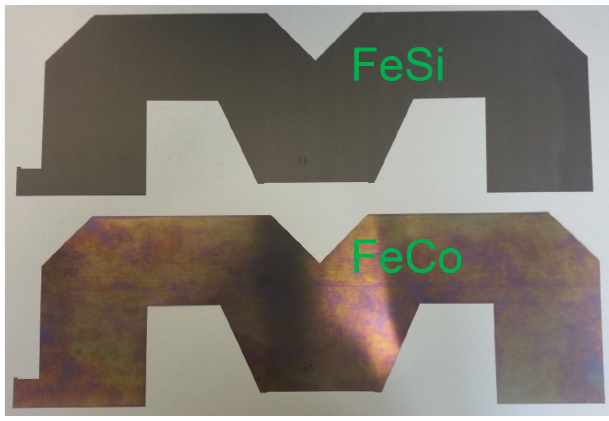
FIG. 10. FeSi and FeCo laminations. The FeCo laminations have a blue/purple color due to the magnesium oxide (MgO) layer.